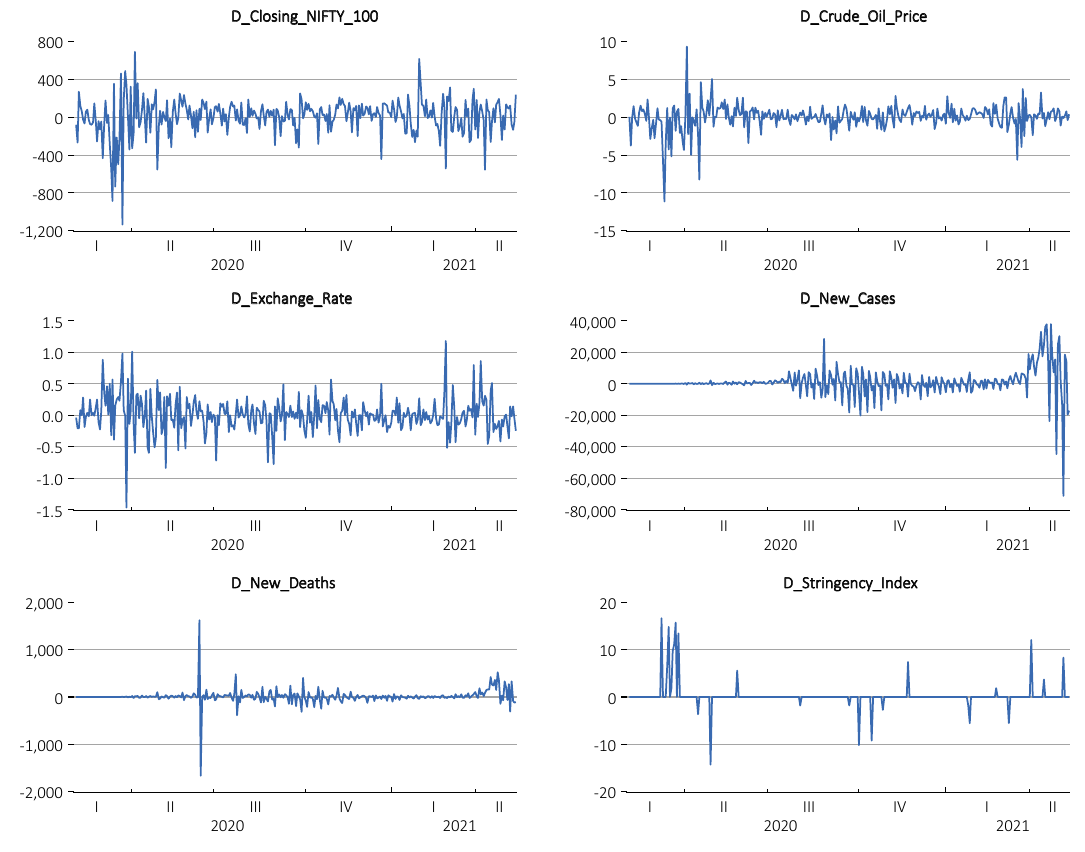
Figure 2. Trend of selected variables at first difference Table 3. Johansen’s cointegration test for cointegrating vectors The Trace Test H